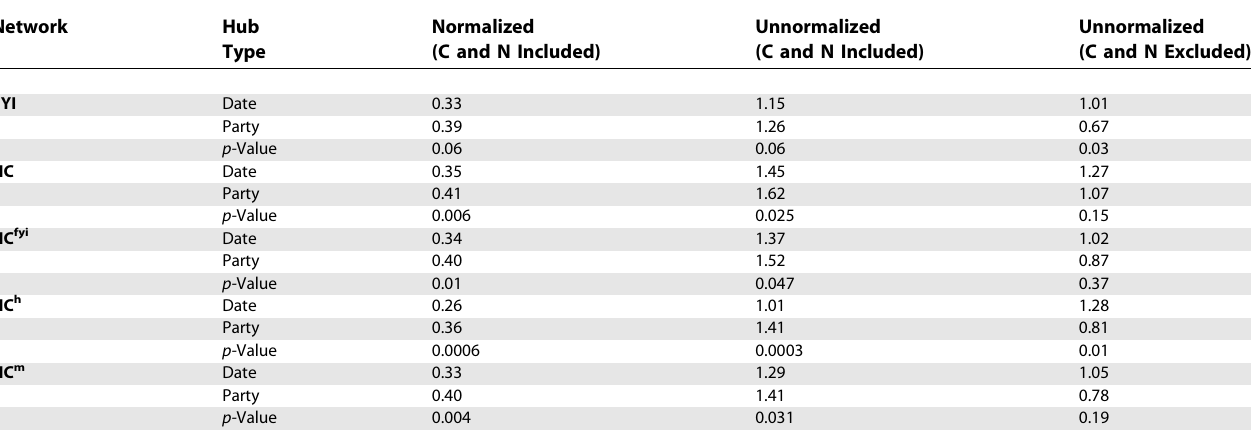
Table 2. Localization Entropy Difference of Hubs Network Hub